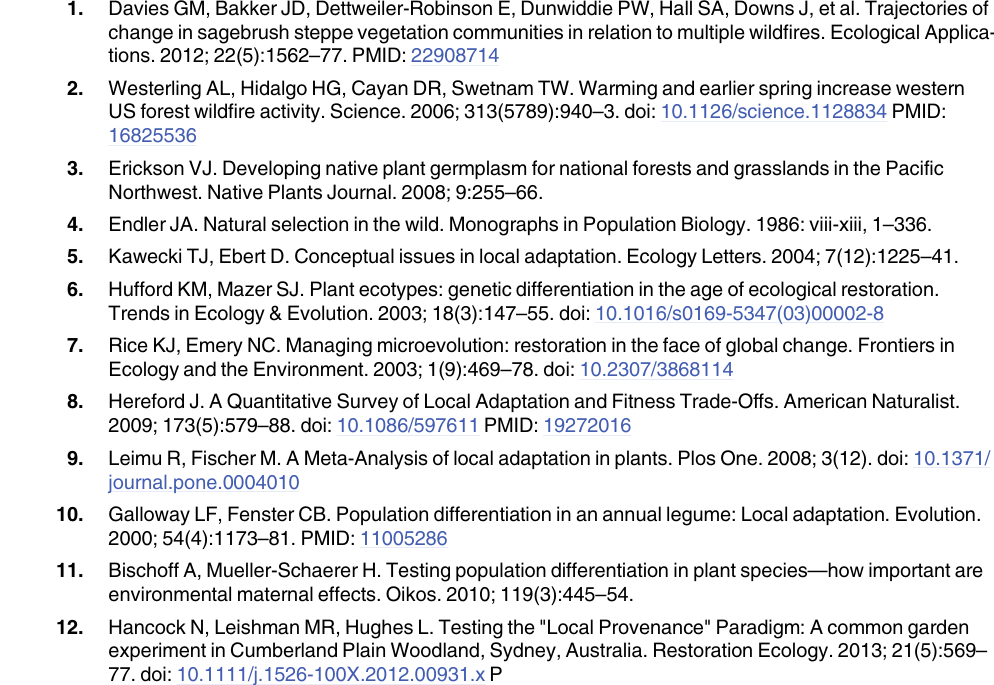
S2 Table. Canonical correlation summary for the first four variates relating plant traits from common gardens and source climates for basin wildrye. S3 Table. Regression models between traits and climates for octoploid (n = 57) and tetra- ploid (n = 52) source populations of basin wildrye in the intermountain West,